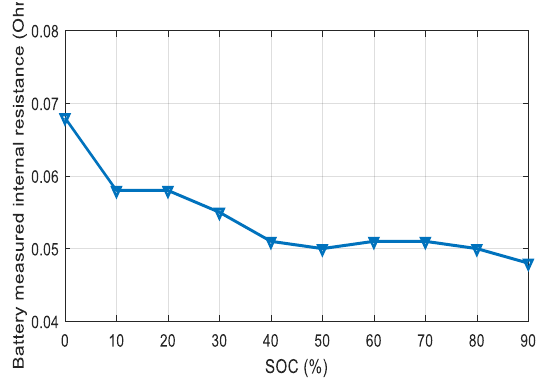
Figure 8. Battery internal resistance experimental measurement. World Electric Vehicle Journal 2020 , 11 , x FOR PEER REVIEW